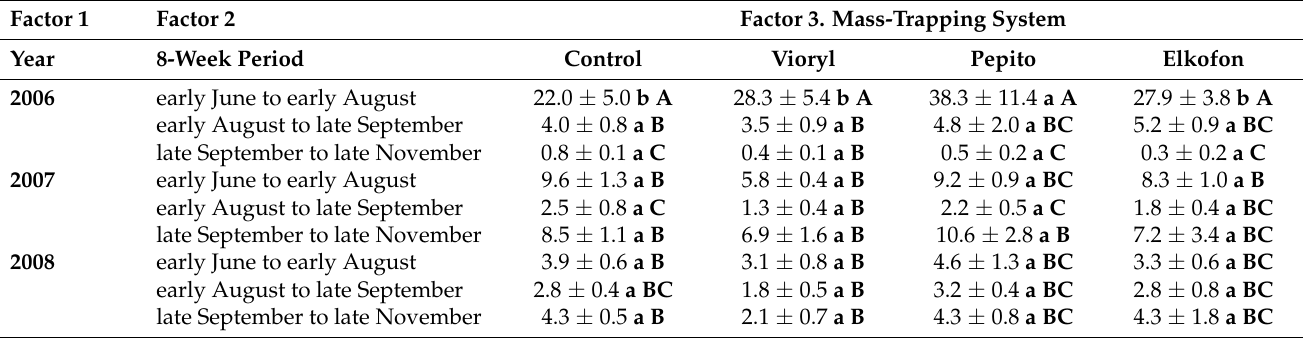
Table 7. Interaction means for the effects of year, 8-week monitoring period and mass-trapping system on olive fly activity determined by McPhail monitoring